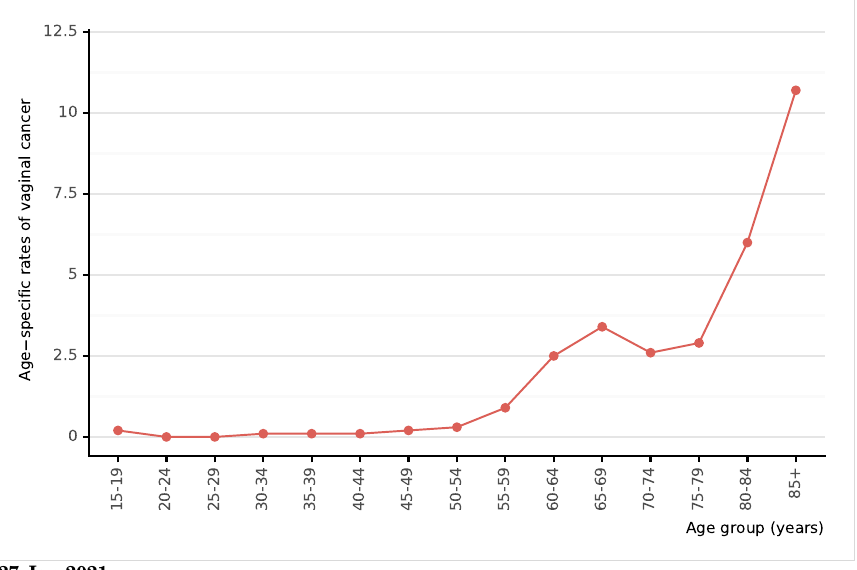
Figure 26: Age-specific incidence rates of vaginal cancer in Peru (estimates for 2020)